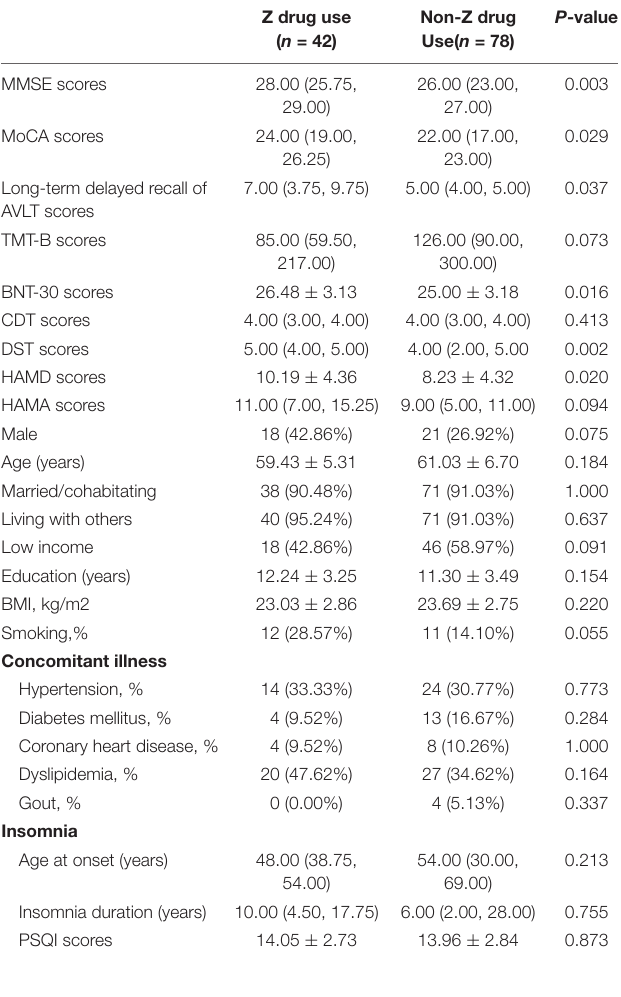
TABLE 5 | Univariate analysis of the correlation between cognition and Z